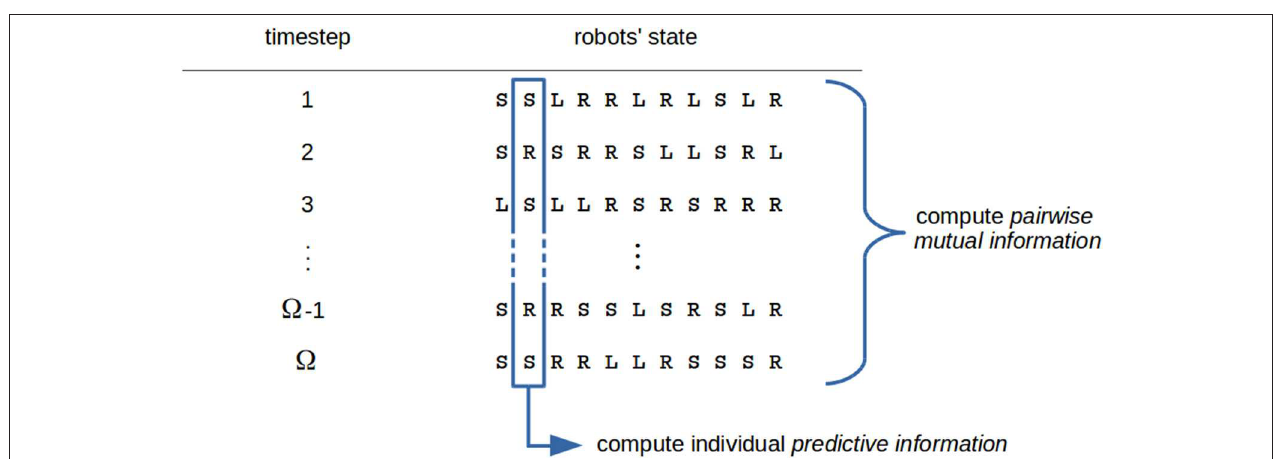
FIGURE 2 | An example of the evaluation of complexity metrics. We suppose that robots are controlled by a probabilistic finite state automaton, hence the swarm state is given by a tuple composed of symbols from a finite alphabet, each representing one state in the automaton (this choice is not a limitation, as it is possible to compute complexity metrics for any choice of the variables representing robots’ state). Individual metrics can be computed by considering the time sequence of states for each robot, while global swarm measures are a function of the whole swarm state (or a portion of it). In the figure, the predictive information (PI) of each robot can be computed on the basis of the time sequence of robot states; conversely, as a swarm measure the average pairwise mutual information can be computed. Indeed, high values of this metric are expected to favor global coordinated behaviors ( Sperati et al., 2014).